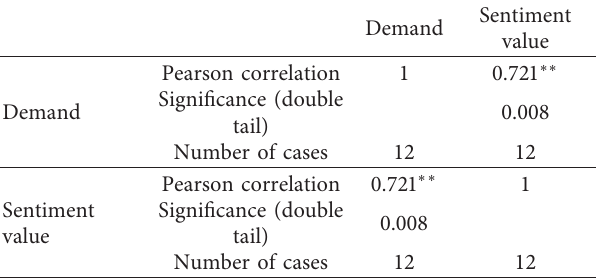
Table 2: Correlation analysis results.